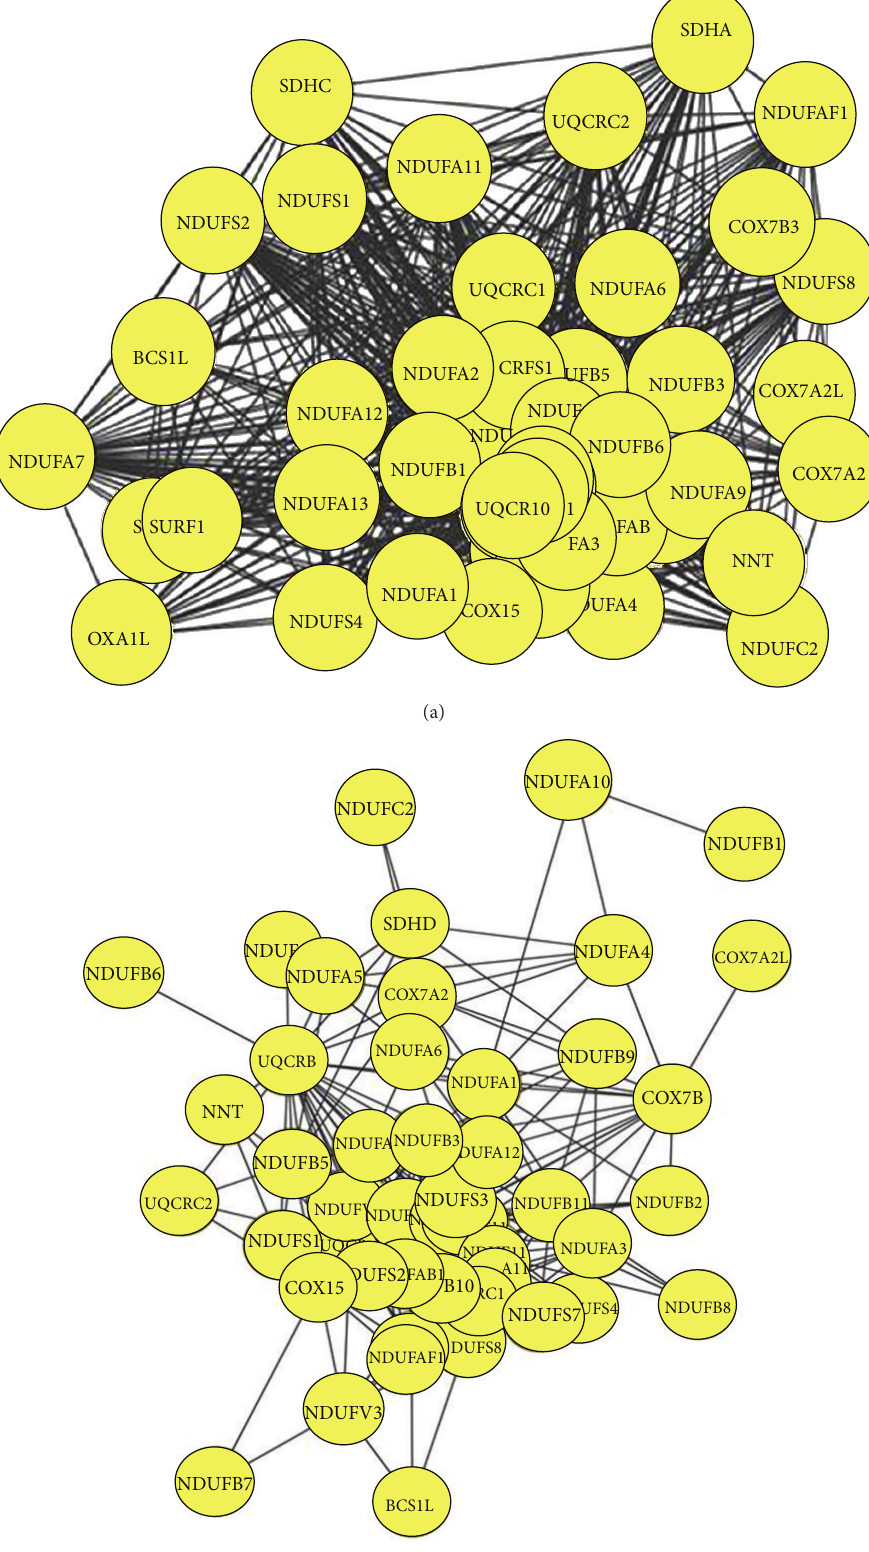
Figure 2: Genes coexpressed with MRCs in (a) the tissue-based network and (b) the chemical treatment-based